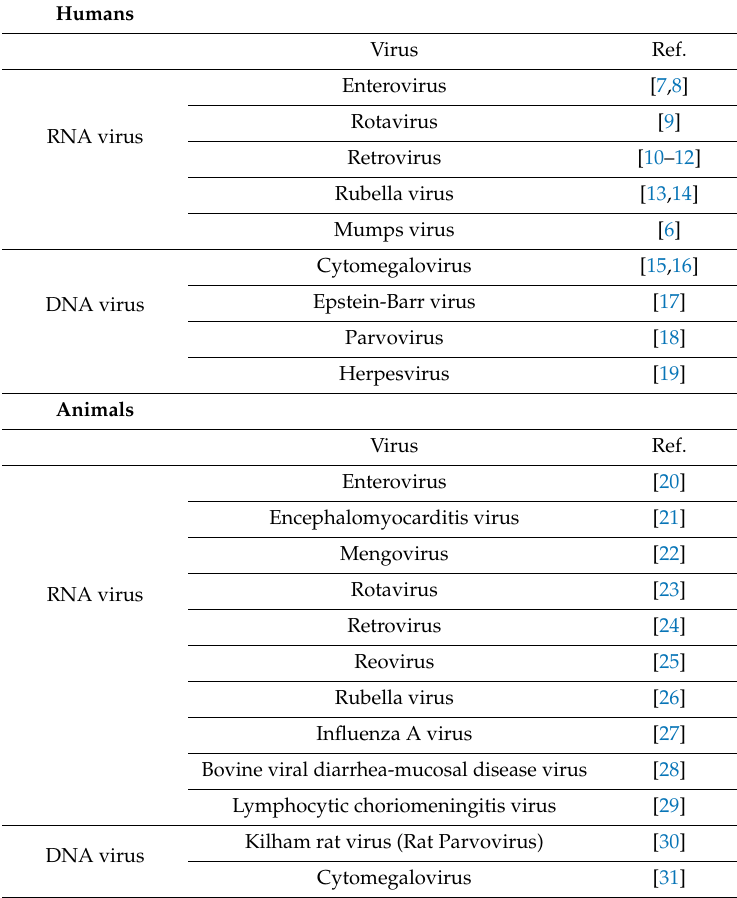
Table 1. List of potential diabetogenic viruses in humans and